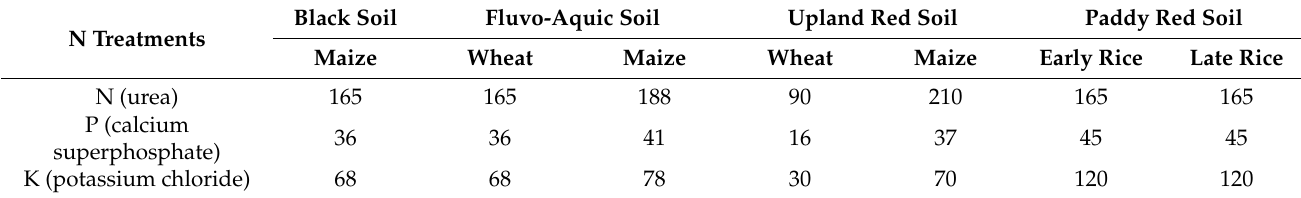
Table 2. Fertilizer application rates for each growing season at the four sites (kg ha − 1